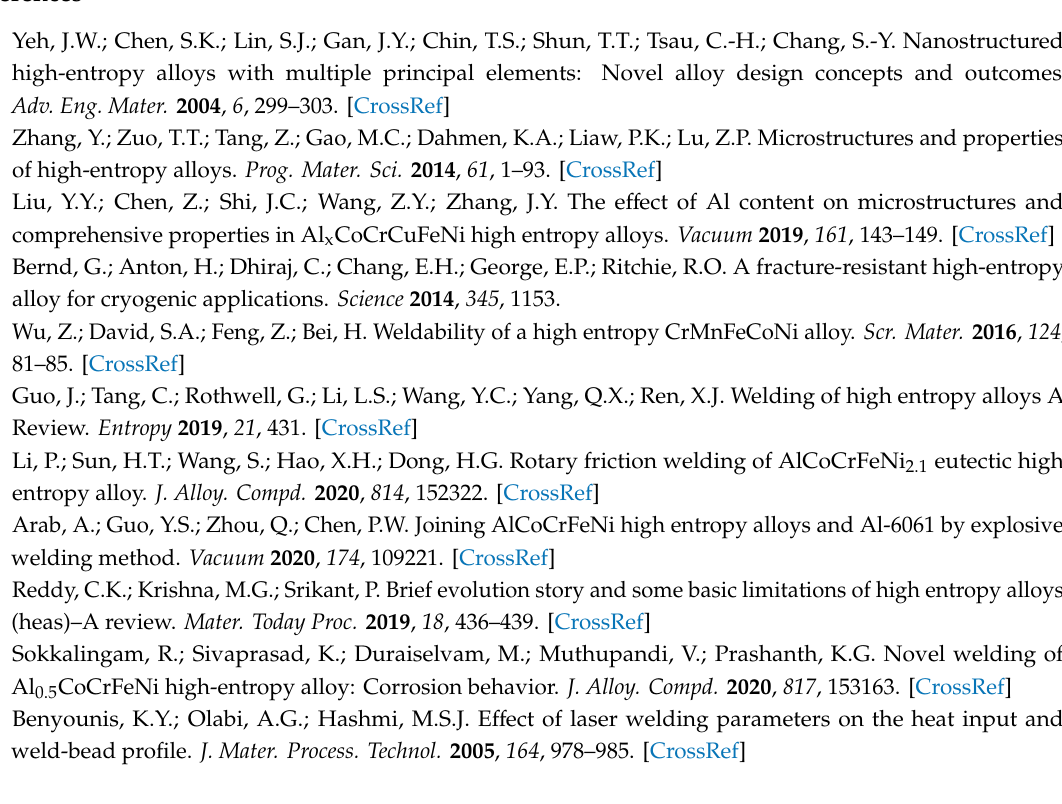
Figure S1: Microstructure of the base (a) and EDS spectrum of the position with marker ( # )(b); Figure S2: Compositional transition from matrix to weld of the Mn element ((a) W1; (b) W2 and (c) W3) and that of the Al element for W3 (d) (the scale “0” denotes the fusion line in each weld); Figure S3: Fractographies contrast of the base (a) and W1 (b); Table S1: The tensile properties of the base and